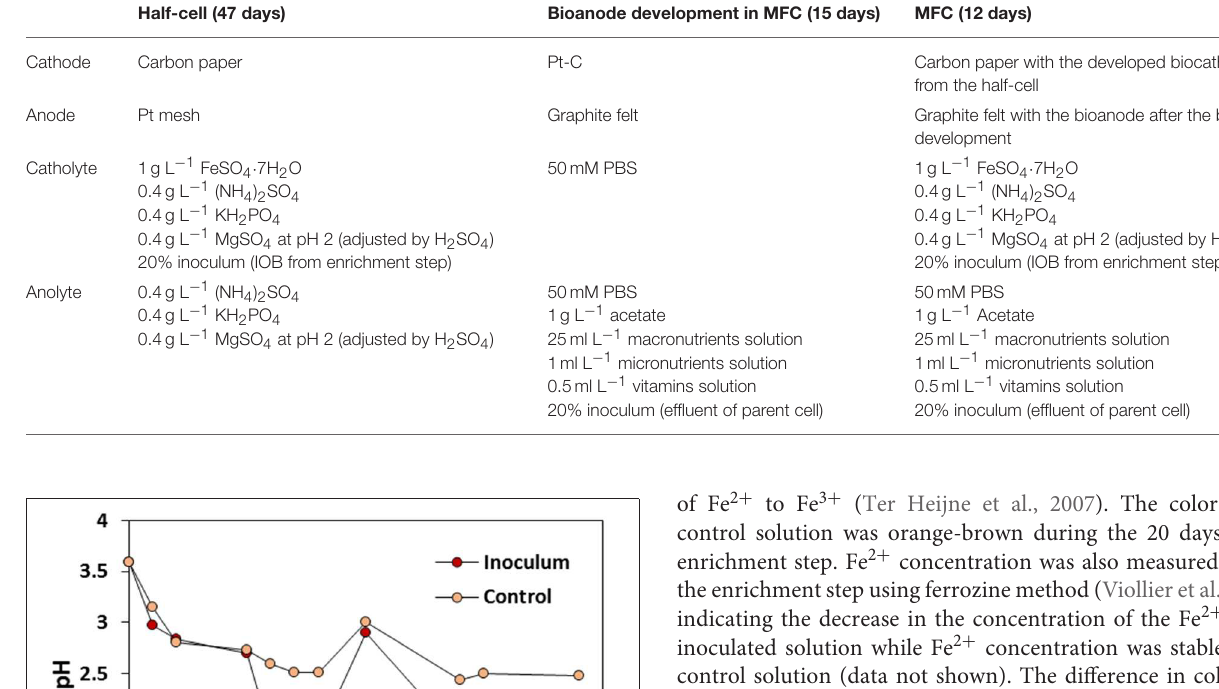
TABLE 1 | BES operation strategy in this study. Half-cell (47 days) Bioanode development in MFC (15 days)